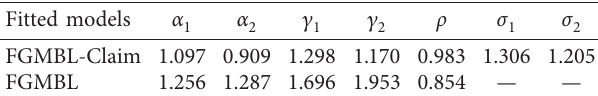
Table 6: MLEs of the competing models for the economics data. Fitted models